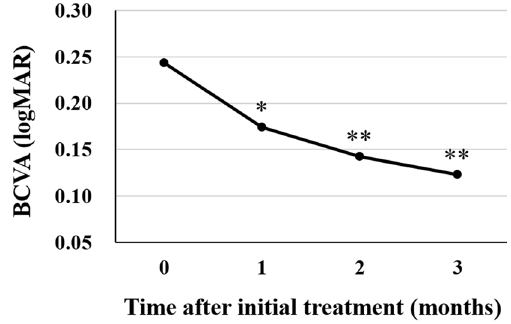
Figure 1. Change of average best-corrected visual acuity (BCVA) in 36 eyes with neovascular age-related macular degeneration associated with type 1 choroidal neovascularization treated with 3 monthly intravitreal injections of brolucizumab. BCVA showed significant improvement after the first injection of brolucizumab (* P < 0.01, ** P < 0.001). Data are expressed as means.